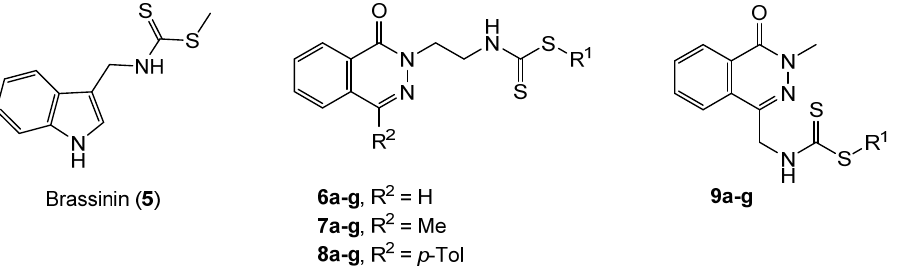
Figure 2. Brassinin ( 5 ) and the novel phthalazinone-dithiocarbamate hybrids (compounds 6 – 9